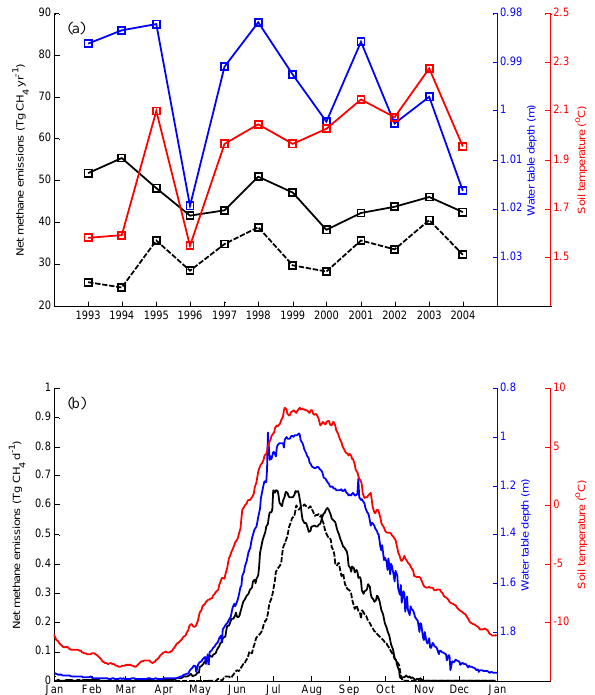
Fig. 4. Inter-annual (a) and seasonal (b) variability of simulated 5km net methane emissions over the pan-Arctic and spatially av- eraged water table depth and top-layer (0–5cm) soil temperature. Mean water table depth and soil temperature during the growing season (May–September) are shown for inter-annual variability, and dashed lines represent simulated methane emissions at a 100km spatial resolution. The daily simulations of the year 1994, hav- ing maximum annual methane emissions at a 5km resolution, are shown for the seasonal variability. Note the water table depth has an inverse y axis different from the